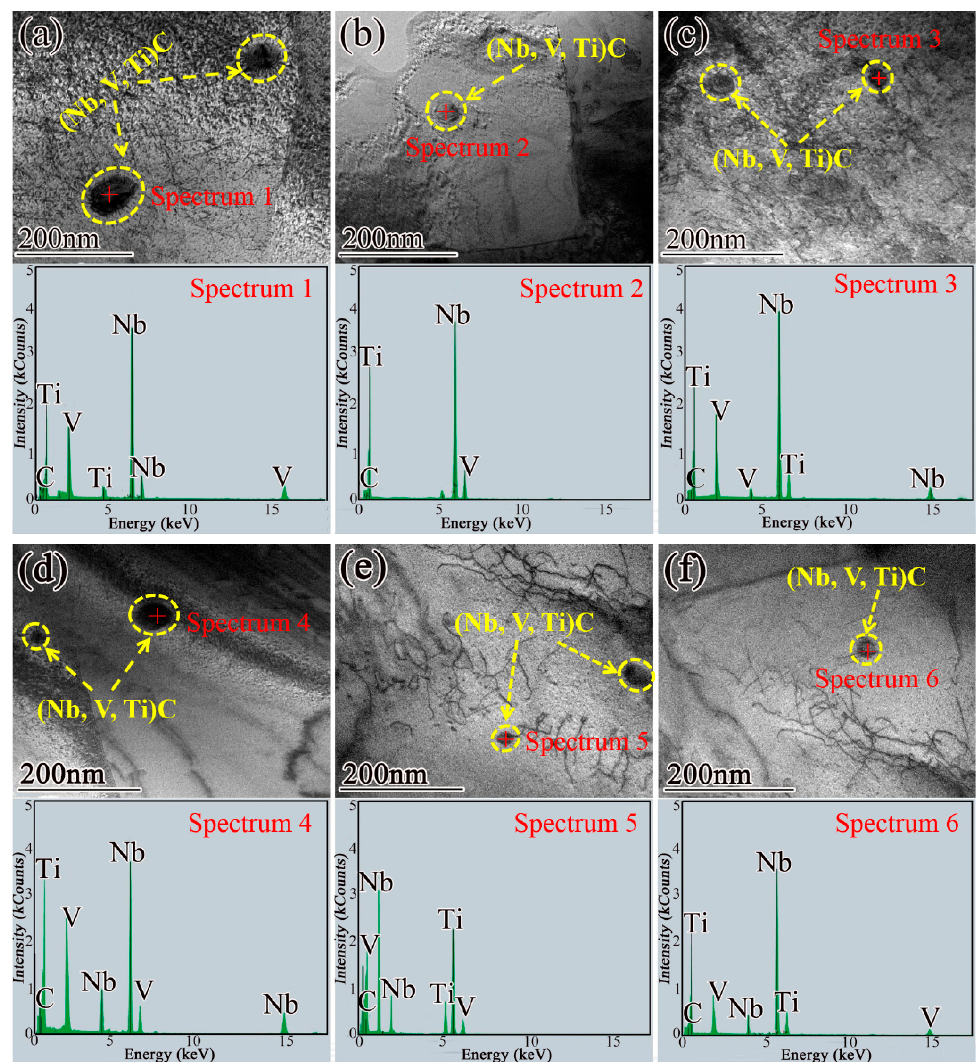
Figure 11. TEM images of precipitates in ( a – c ) steel 1# and ( d – f ) steel 2# at different cooling rates: ( a , d ) 0.3 °C/s, ( b , e ) 1 °C/s, ( c – f ) 5 °C/s.